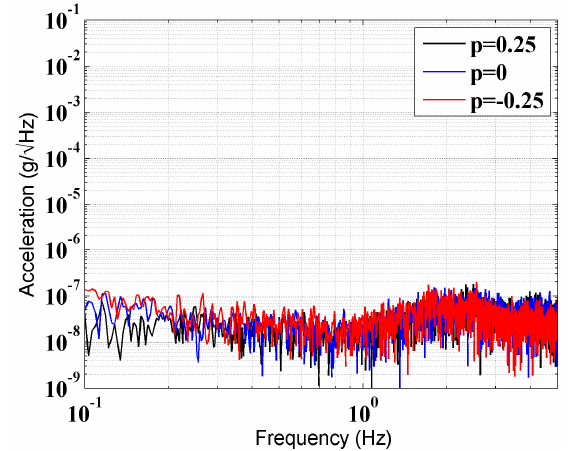
Figure 6. ASD of the trimmed accelerometer with three different coefficients p .